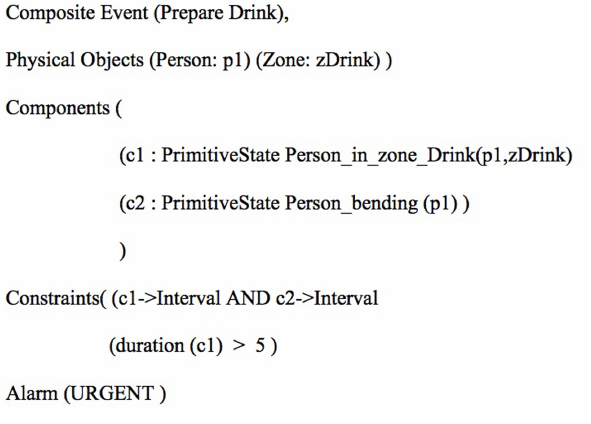
FIGURE 2 | Presents an example of event model for the recognition of preparing drink event following the ontology language